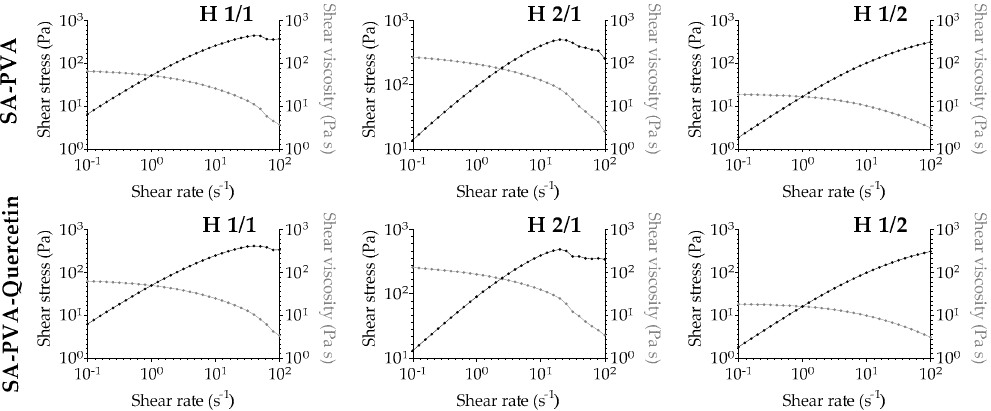
Figure 3. Viscosimetry analysis of unloaded (top row) and quercetin-loaded (bottom row) SA-PVA hydrogels, through shear stress (black line) and shear viscosity (grey line) data.